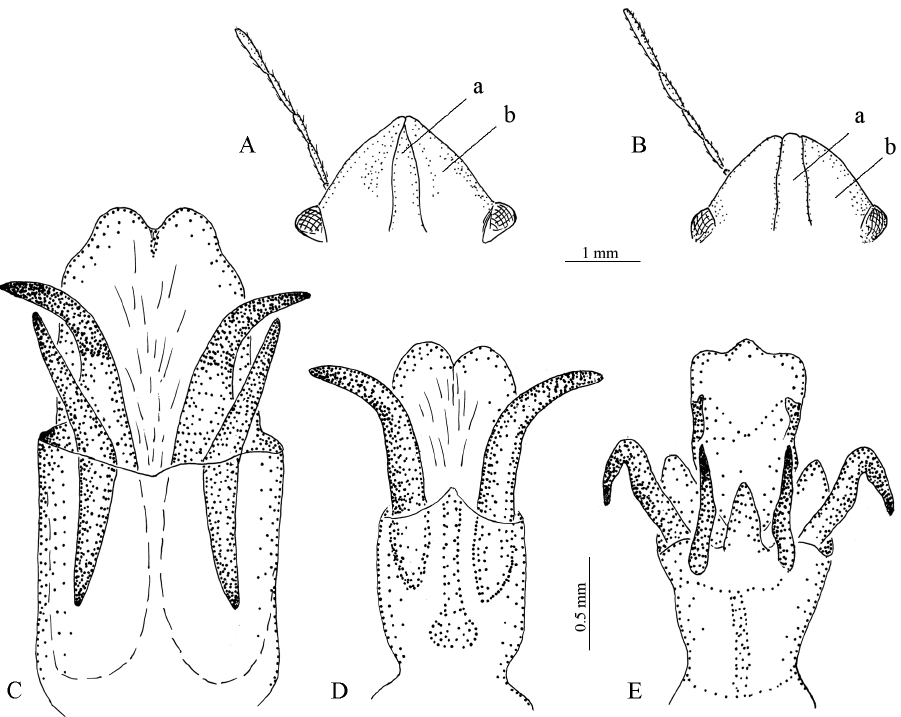
Figure 7. Structural details of Eurygaster Laporte species (a, clypeus; b, jugal plate): A E. austriaca (Schrank), head, dorsal view B E. integriceps (Puton), dorsal view C E. integriceps , aedeagus D E. maura L., aedeagus E E. testudinaria (Geoffroy), aedeagus (after Golub, 1980, with